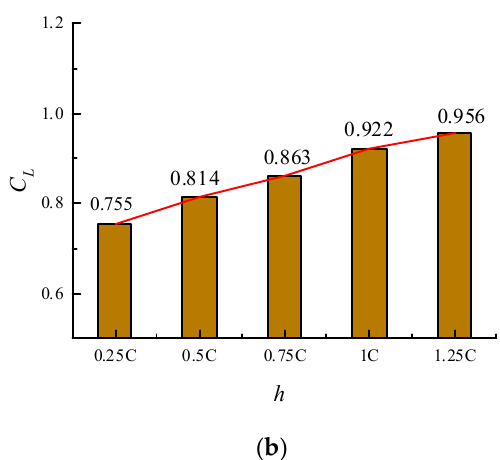
Figure 18. Comparison of the lift coefficient fluctuation and the average value at different water depth. ( a ) Lift coefficient fluctuations at different water depths; ( b ) Average lift coefficient at different water depths.